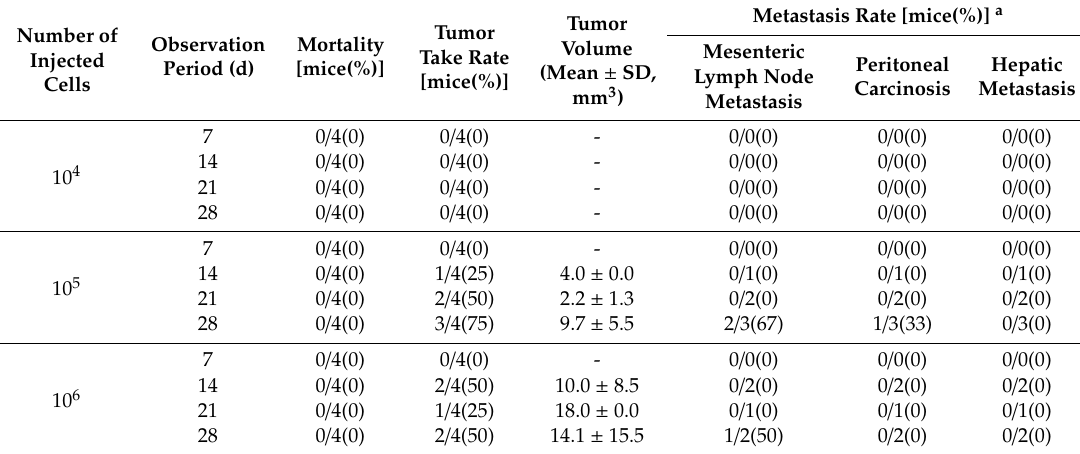
a Mice with metastasis / mice with primary tumor growth in the